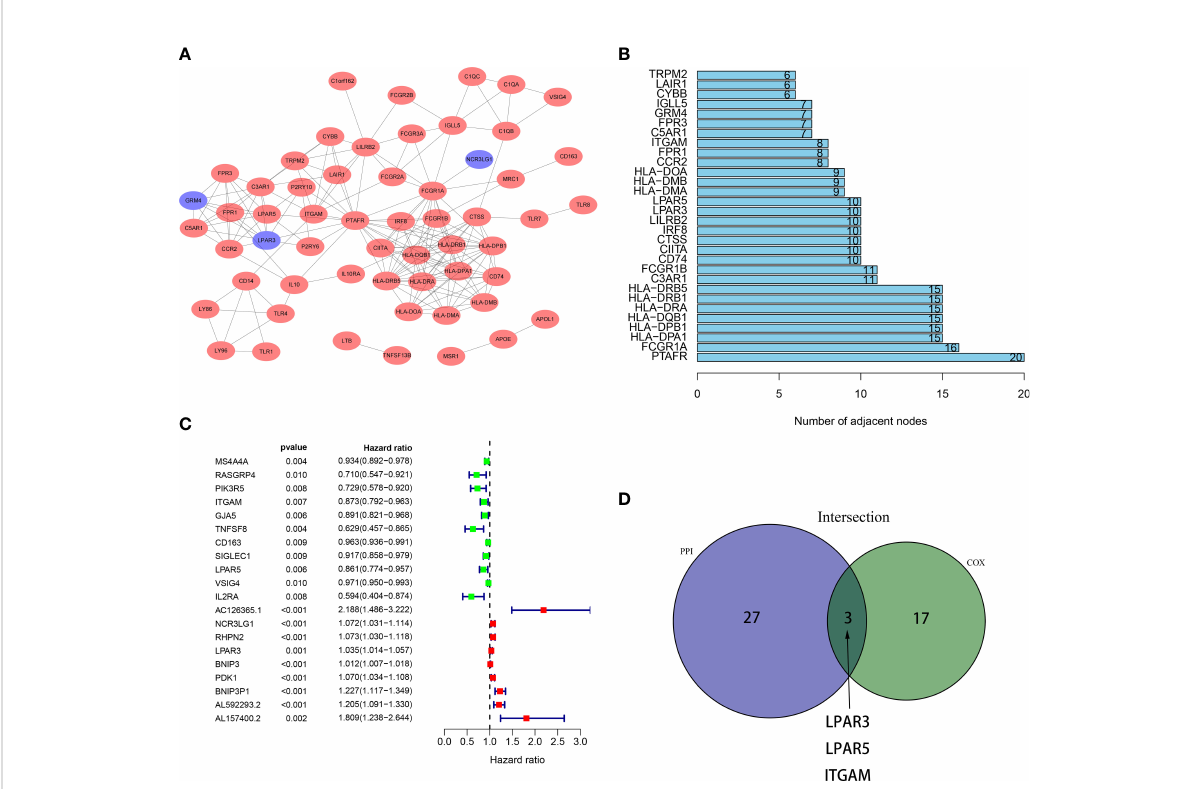
FIGURE 4 Intersection of results from PPI network and univariate Cox regression. (A) A PPI network was constructed based on DEGs with an interaction con fi dence value >0.90. The red ellipses represent up-regulated genes, and the blue ellipses represent down-regulated genes. (B) The top 30 gene nodes in the PPI network. (C) Univariate COX regression analysis revealed 20 prognostic genes. (D) A venn diagram showed 3 key genes shared by the PPI network and univariate Cox